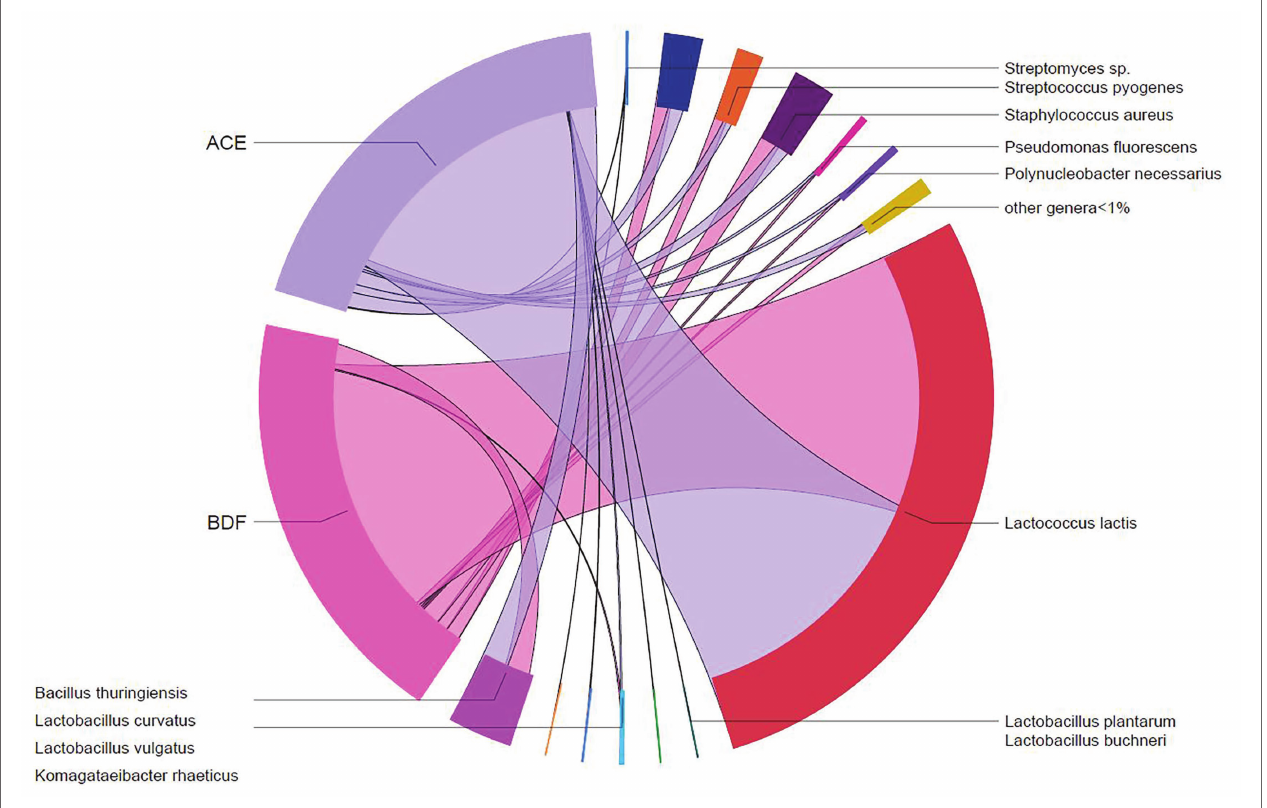
FIGURE 3 | Shared taxa between the two types of Gouda cheeses (ACE, uninoculated and BDF, inoculated) produced in this